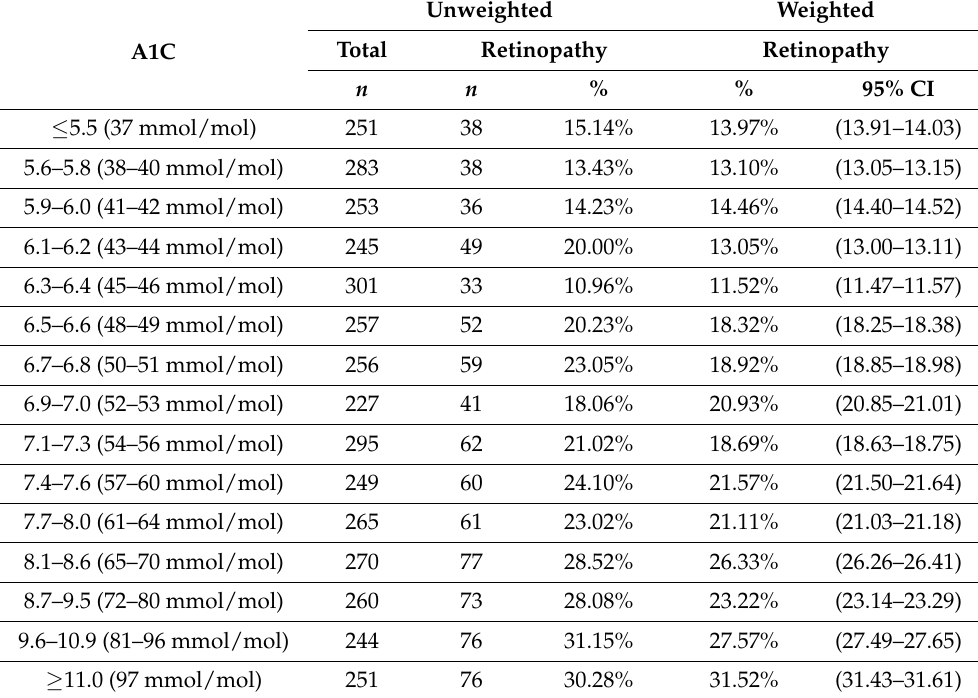
Table 5. Prevalence of diabetic retinopathy based on A1C categories in subjects with established